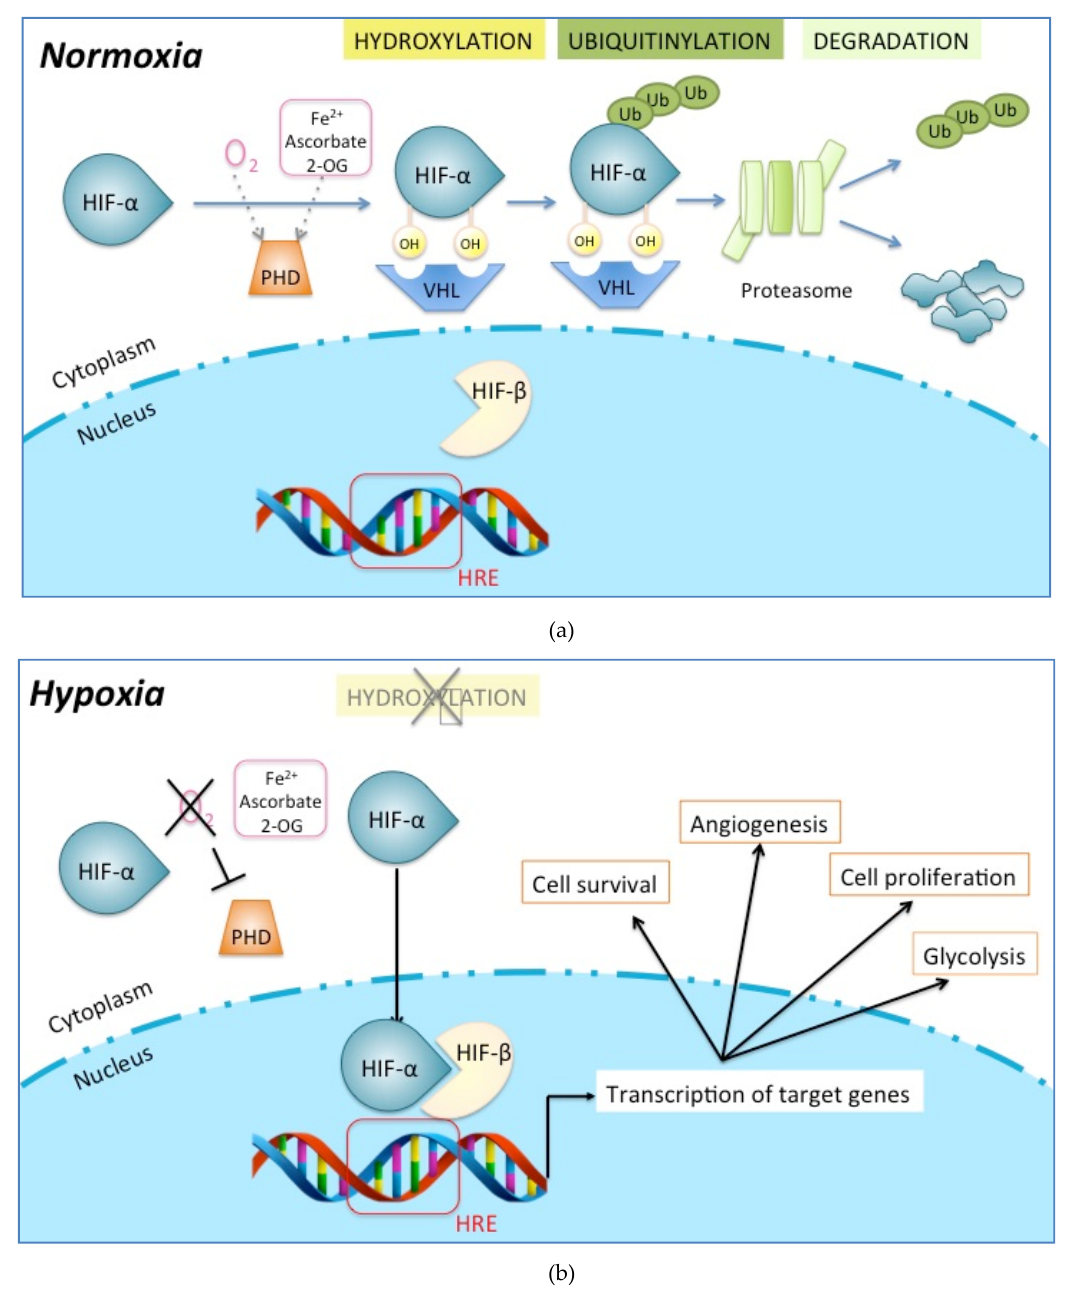
Figure 4. Molecular mechanisms of oxygen sensing and signaling. ( a ) In normoxia, hypoxia-inducible factor- α subunit (HIF- α ) is hydroxylated through a combination of α -ketoglutarate, molecular oxygen (O 2 ), one or more of the prolyl hydroxylase (PHD) isoenzymes and the asparaginyl hydroxylase factor inhibiting HIF (grey dotted arrow). The von Hippel–Lindau protein (VHL)-containing E3 ubiquitin ligase targets the α -subunit for polyubiquitylation and degradation in the proteasome. ( b ) In hypoxia, low oxygen (black cross line) causes inactivation of PHD (black T arrow). The α -subunit is no longer hydroxylated (grey cross line) and becomes stabilized. In the nucleus, HIF- α binds to the HIF- β subunit and with the help of cofactors, the complex becomes transcriptionally active upon binding to the hypoxia-responsive element (HRE, red box) consensus sequence on the promoter of target genes. HIF-target genes are numerous, with key roles in cell survival, angiogenesis, proliferation, and glycolysis.